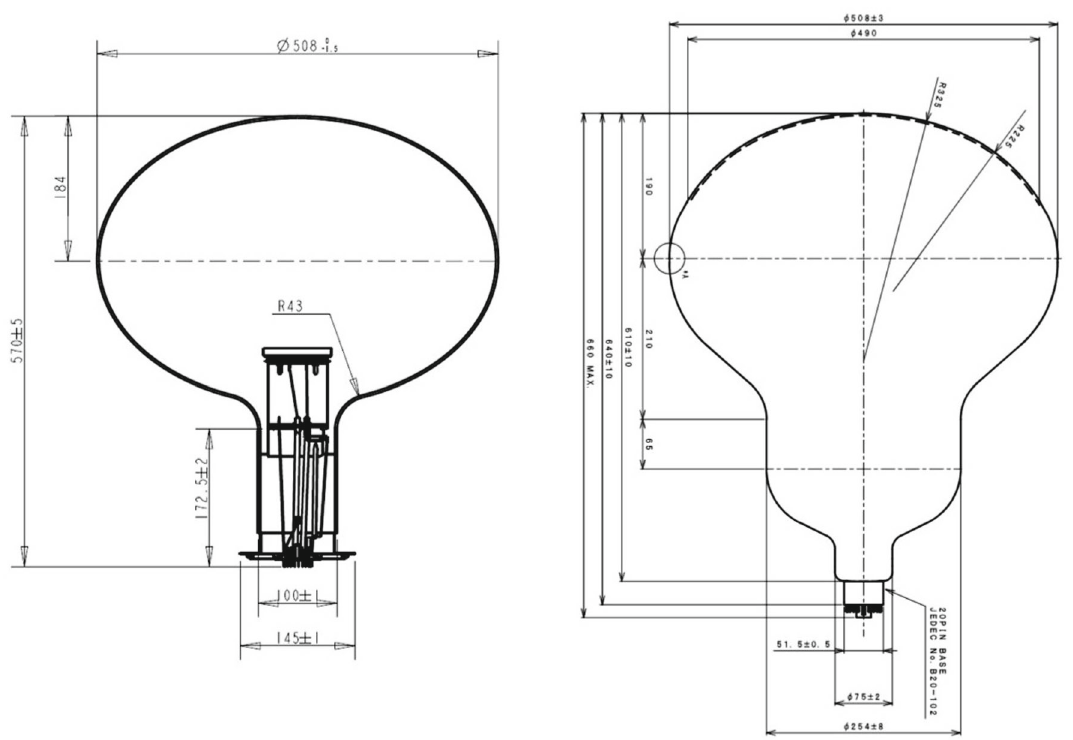
Fig. 2 Technical drawing of selected PMTs for JUNO: NNVT 20-inch MCP-PMT (type GDB-6201 [63], left) and HPK 20-inch dynode PMT (type R12860 [59],